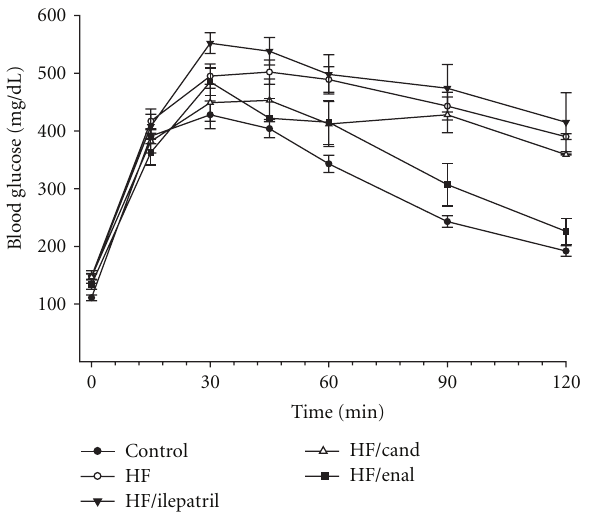
Figure 3: Plasma glucose concentration curve during intraperi- toneal glucose tolerance test (IPGTT) for C57Bl/6J mice fed a normal or high-fat-containing diet for 24 weeks and the high-fat diet with or without ilepatril, candoxatril, or enalapril for the last 12 weeks (intervention protocol). Data are the mean ± SEM in mM. Fasting basal blood glucose levels were 111 ± 5, 148 ± 5, 177 ± 11, 147 ± 6, and 134 ± 8 mg/dL for control, high fat, high fat + ilepatril, high fat + candoxatril, and high fat + enalapril, respectively. Control (closed circles), high fat (open circles), high fat + ilepatril (closed innervated triangle), high fat + candoxatril (open triangle), and high fat + enalapril (closed rectangle). The area under the curve (AUC) was significantly di ff erent P < 0 . 05 for high-fat-fed mice versus control and high-fat-fed mice treated with ilepatril versus control. There was no significant di ff erence for AUC between mice fed a high-fat diet containing candoxatril or enalapril versus control. The number of mice in each group was the same as shown in Table 2.